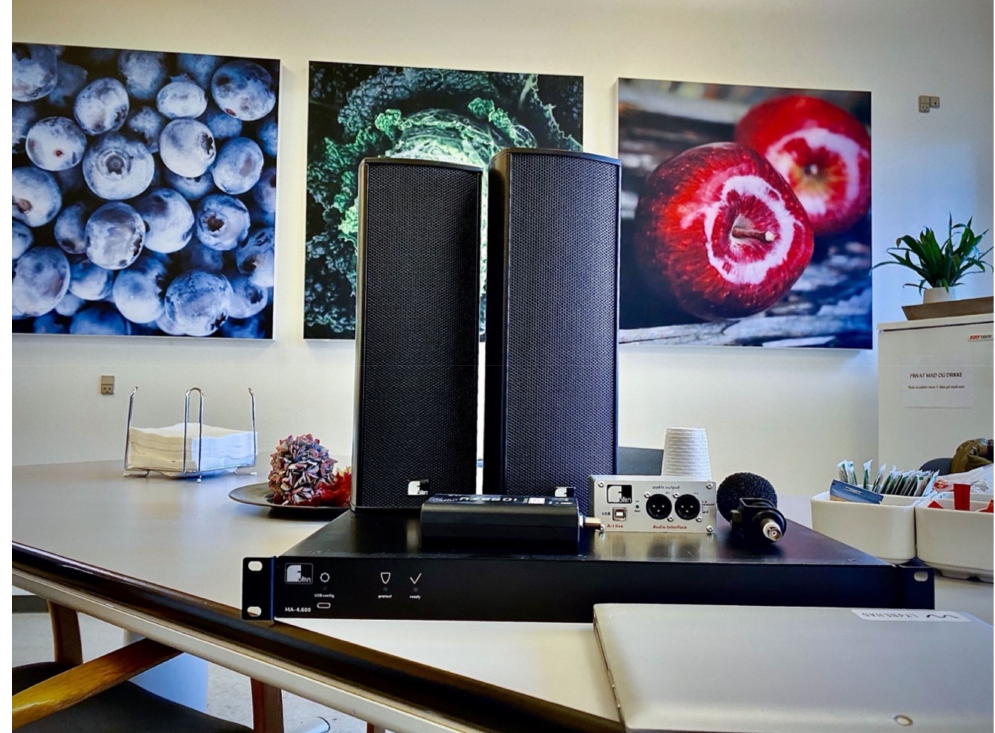
Figure 2. Acoustic and audio equipment. Panels: AKUART On the Wall 60 wall absorbers. Audio equipment: Fohhn